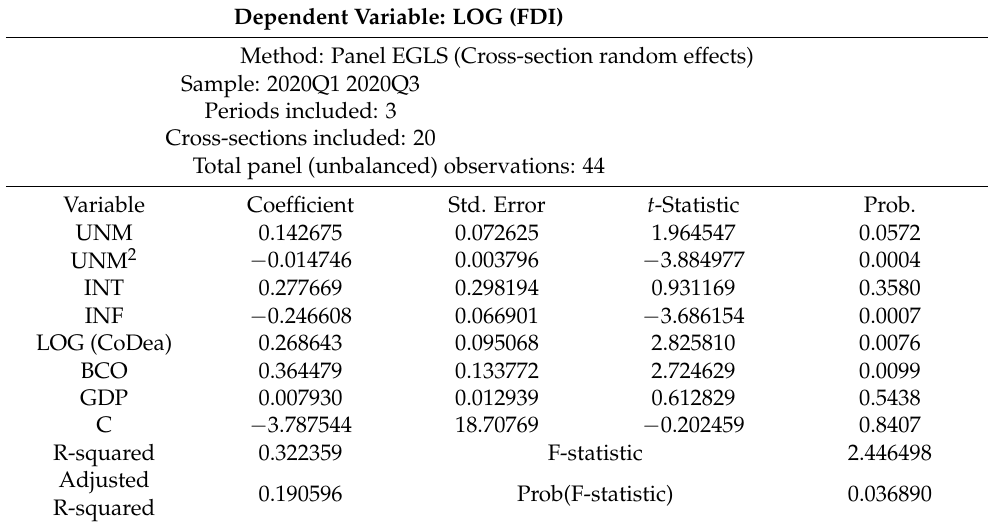
Table 5. Random effects model